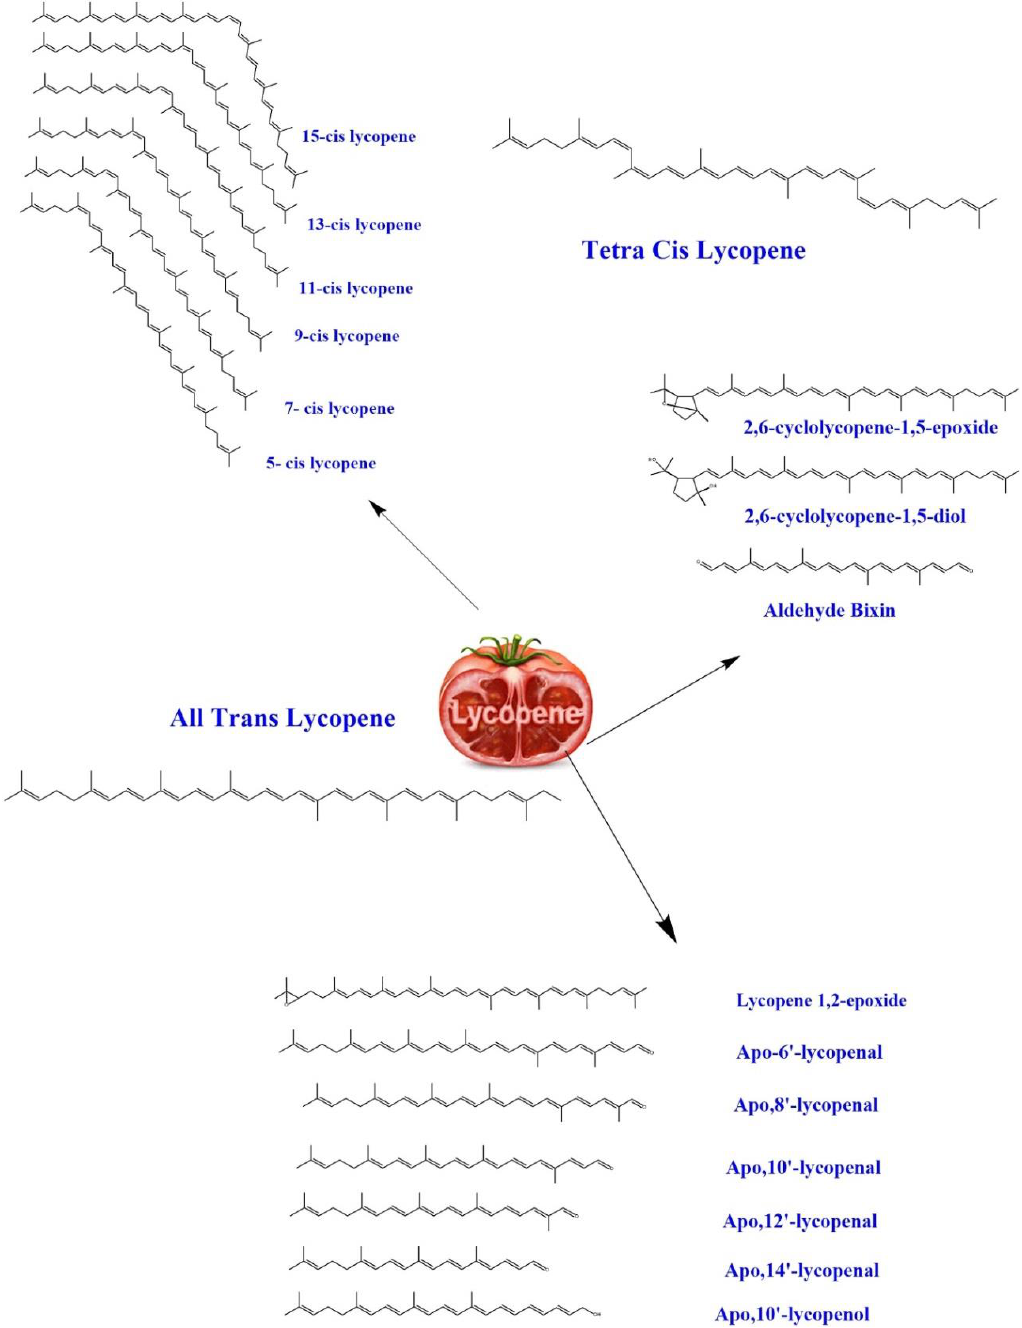
Figure 1. The molecular structures of lycopene and its derivatives and isomers.